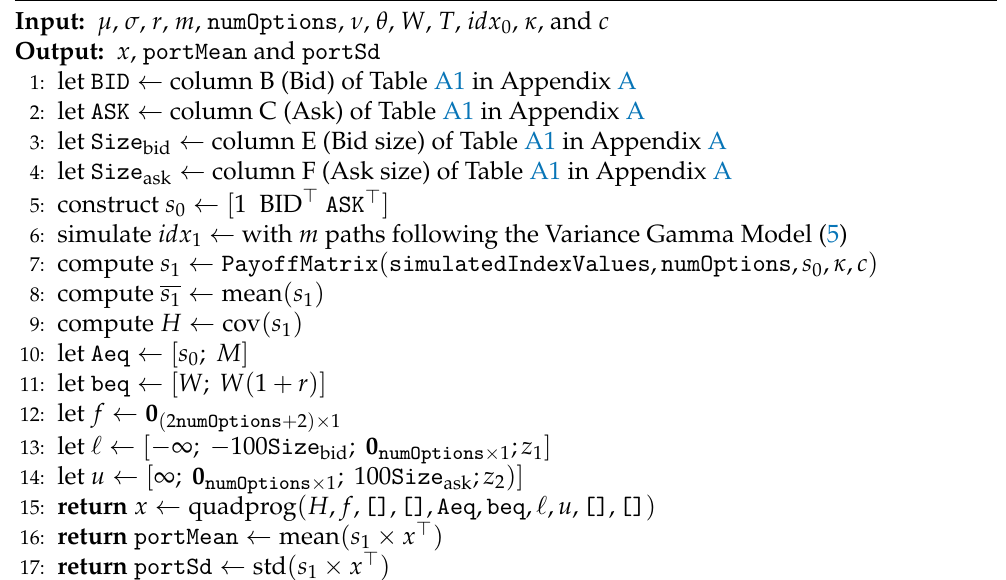
Algorithm 2: Variance minimization ( VarianceMinimize